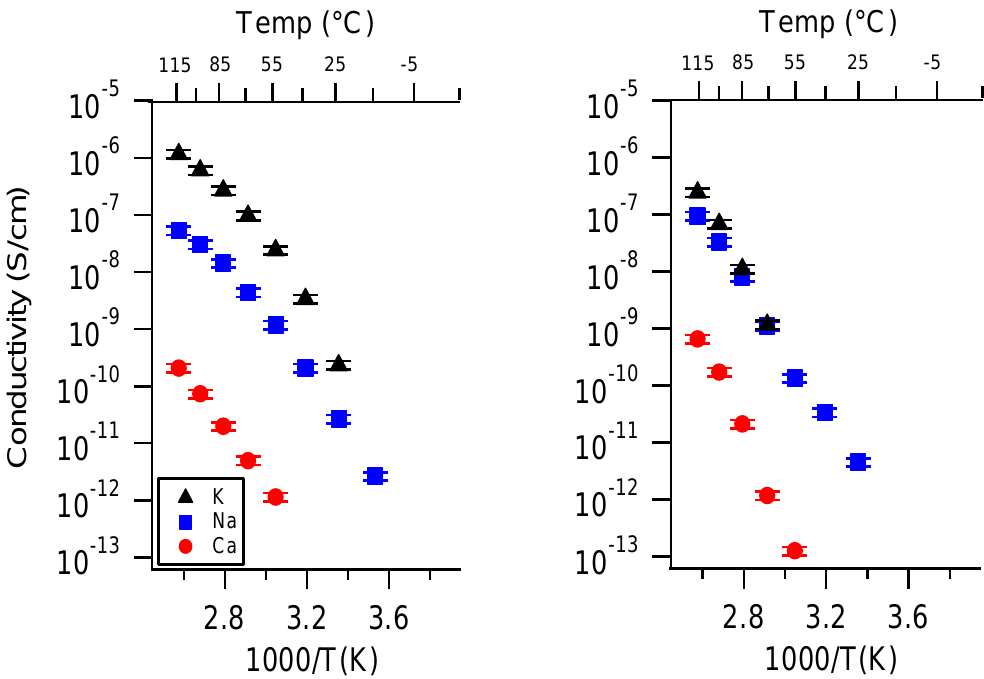
Figure A11. Conductivity as a function of cation for PEGDMA1000_med_SSM (left) and PTHFDA1000_med_STFSI (right) SIPEs dry. Temperatures ranged from − 20 °C to 115 °C. Note that there may be a non ‐ negligible fraction of electronic conductivity in conditions where conductivity of less than 10 − 9 S/cm is reported.